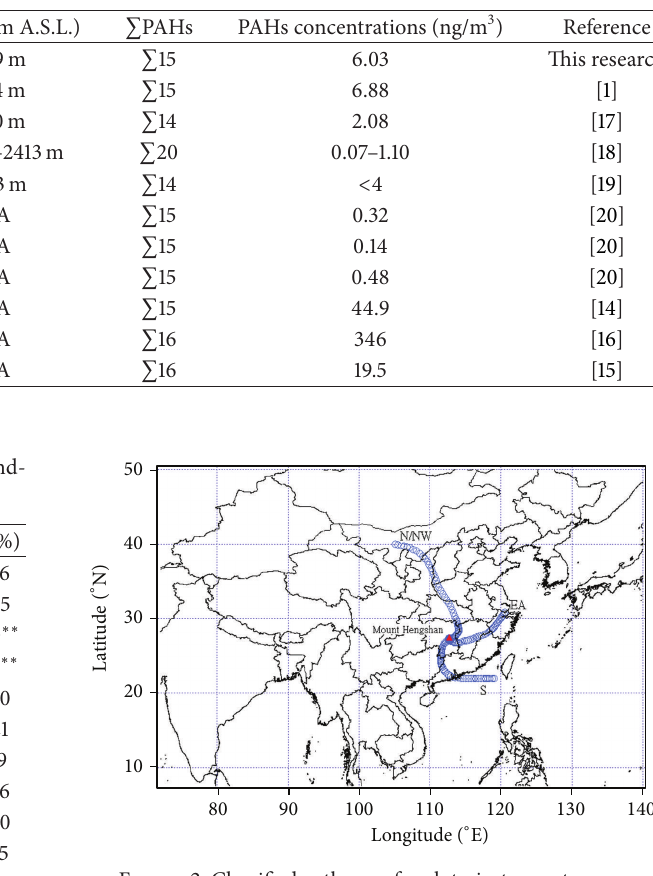
Figure 2: Classified pathway of each trajectory category.